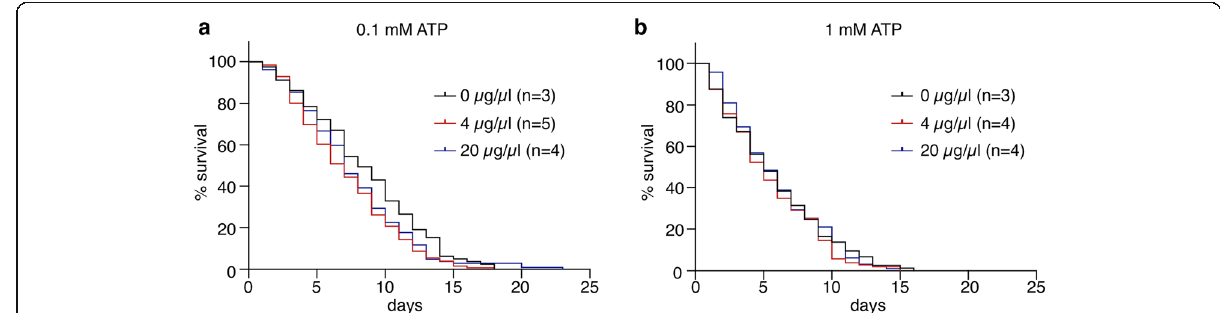
Fig. 2 Influence of ingesting food dyes on survival and longevity of mosquitoes. a , b Survival rate of Ae. aegypti female mosquitoes that sucked 0.1 mM ( a ) or 1 mM ( b ) ATP solution containing either 4 μ g/ μ l or 20 μ g/ μ l green dye. The survival rate of 20 – 30 engorged mosquitoes was followed each day after membrane feeding. All experiments were performed more than three times. No significant difference was found in the Kaplan – Meier log-rank (Mantel-Cox) test (0.1 mM ATP, p = 0.0576; 1 mM ATP, p =